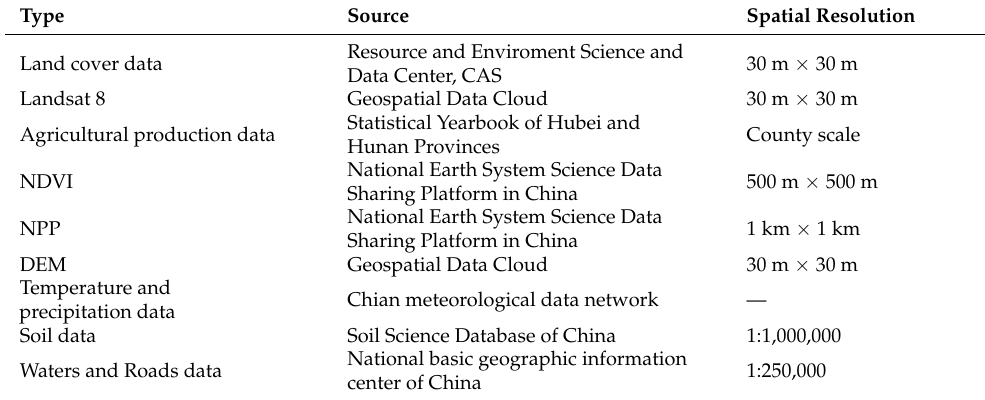
Table 3. Type, sources and spatial resolution of data used in this study.